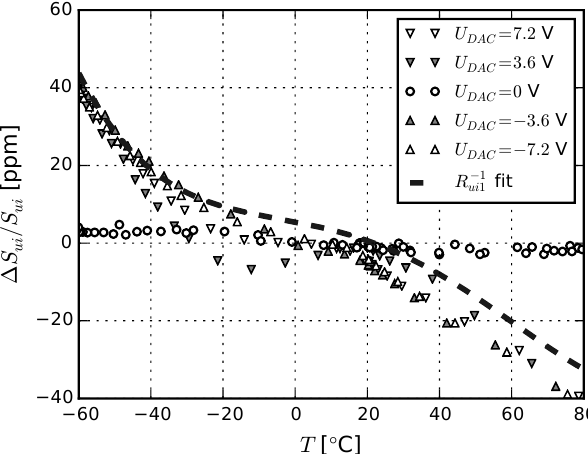
Figure 7. Temperature drift of the voltage reference inverter scale factor and the DAC zero offset.